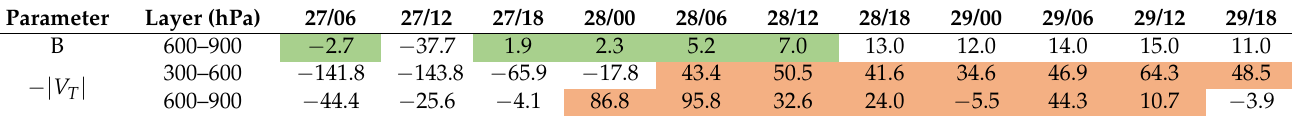
Table 1. Temporal variation of 600 – 900 hPa thermal wind ( −𝑉 𝑇𝐿 ) , 300 – 600 hPa thermal wind (−𝑉 𝑇𝑈 ) and parameter B for the layer 600–900 hPa at a radius of 200 km around the centre of the minimum SLP every 6 h. Green colour indicates symmetry and red colour warm-core system.